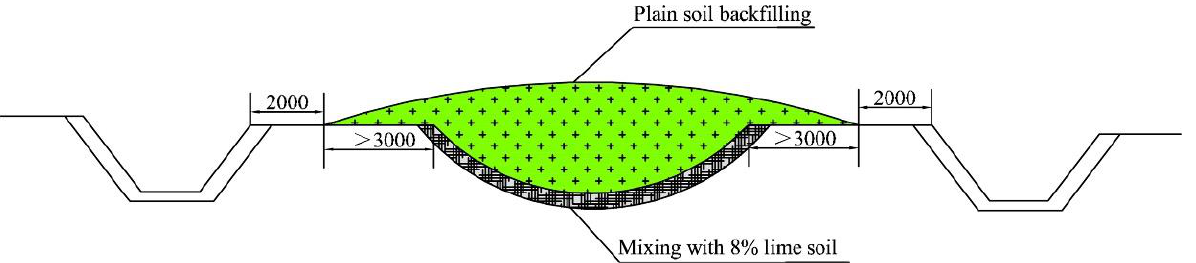
Figure 6. Schematic diagram of advance pipe shed support: ( a ) cross-section; ( b ) longitudinal sec- tion.